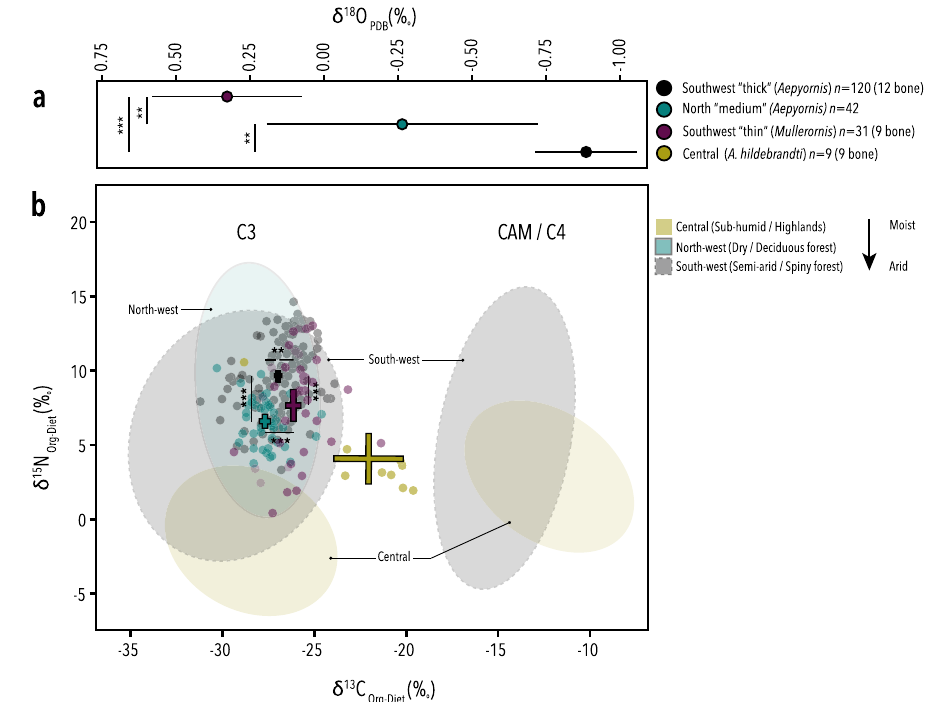
Fig. 4 | Dietary stable isotope content of Aepyornis and Mullerornis eggshells from southern and northern Madagascar. a The mean δ 13 O PBD isotope content. b The mean δ 13 C Diet and δ 13 N Diet isotope content from the organic fraction of in relationtothepreviouslypublishedcarbonisotopedistributionofC3,CAMandC4 photosynthetic plants from each bioregion (ellipses). Coloured crosses represent 95% con fi dence intervals of the mean for each morphotype. Asterisks indicate